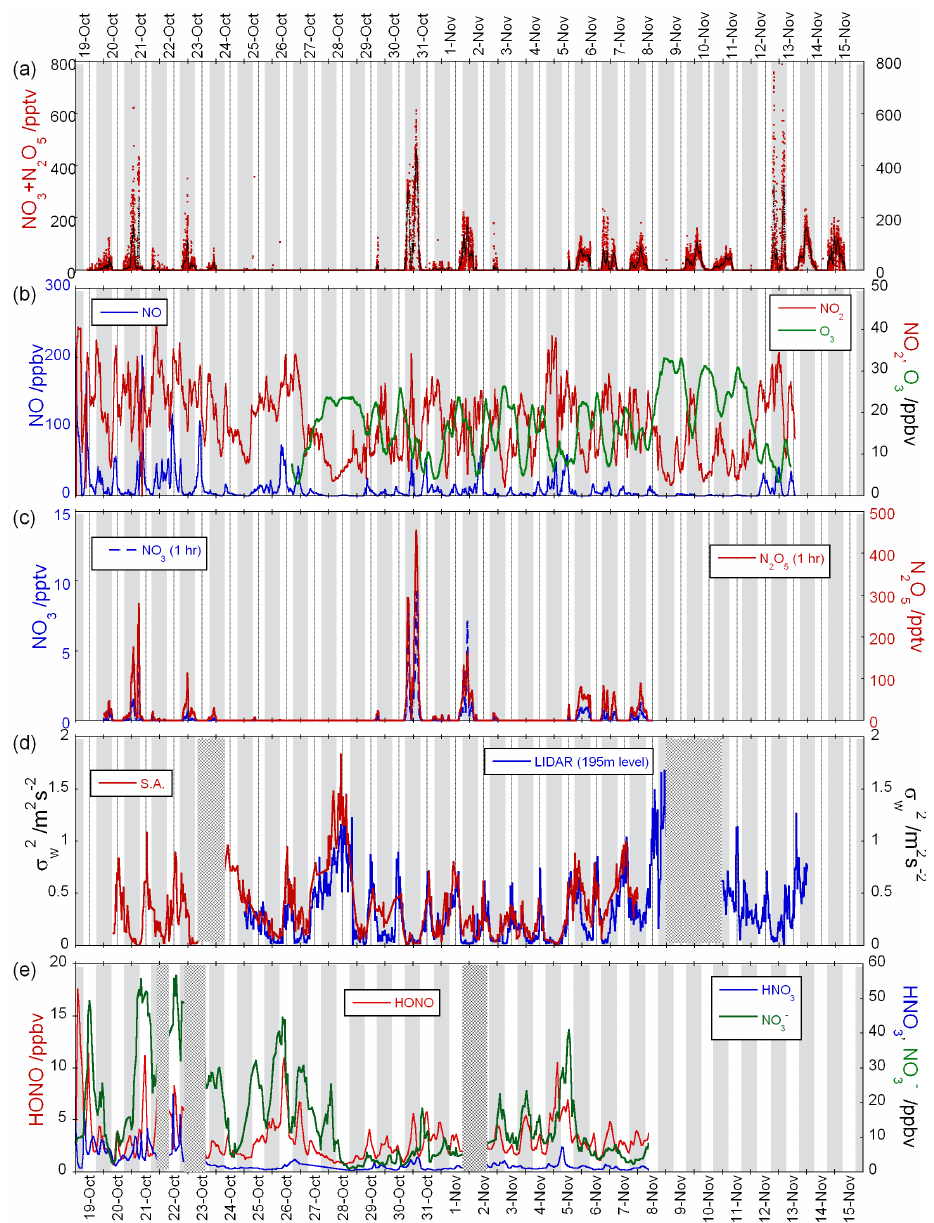
Fig. 7. A summarised time series of measurements during REPARTEE-II. (a) LED-BBCEAS retrieved NO 3 +N 2 O 5 (red points), 1h moving mean (black line). (b) Mixing ratios of NO, NO 2 and O 3 ; (c) mixing ratios of NO 3 and N 2 O 5 as inferred from measurements in panels (a) and (b). Panel (c) Depicts the standard deviation of the vertical velocity variance ( σ 2 w ) , a measure of turbulence in the vertical direction, as indicated by nearby lidar measurements (see text) at its nearest vertical level of 195m, and by the ultrasonic anemometer (S.A.) above the tower. Panel (e) shows nitrous acid (HONO), nitric acid (HNO 3 ) and nitrate aerosol (NO − depict no